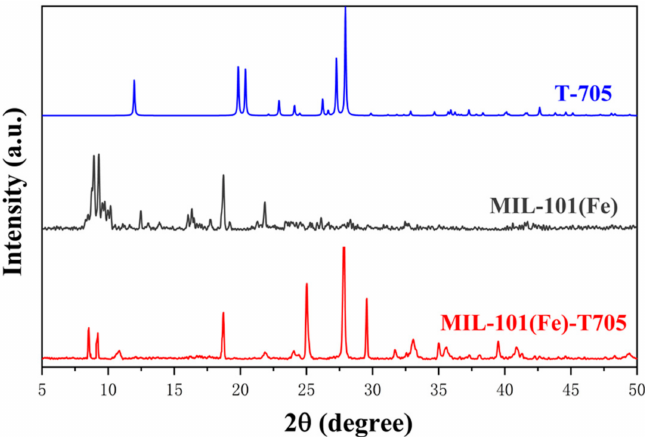
Figure 2. XRD patterns of the as-prepared